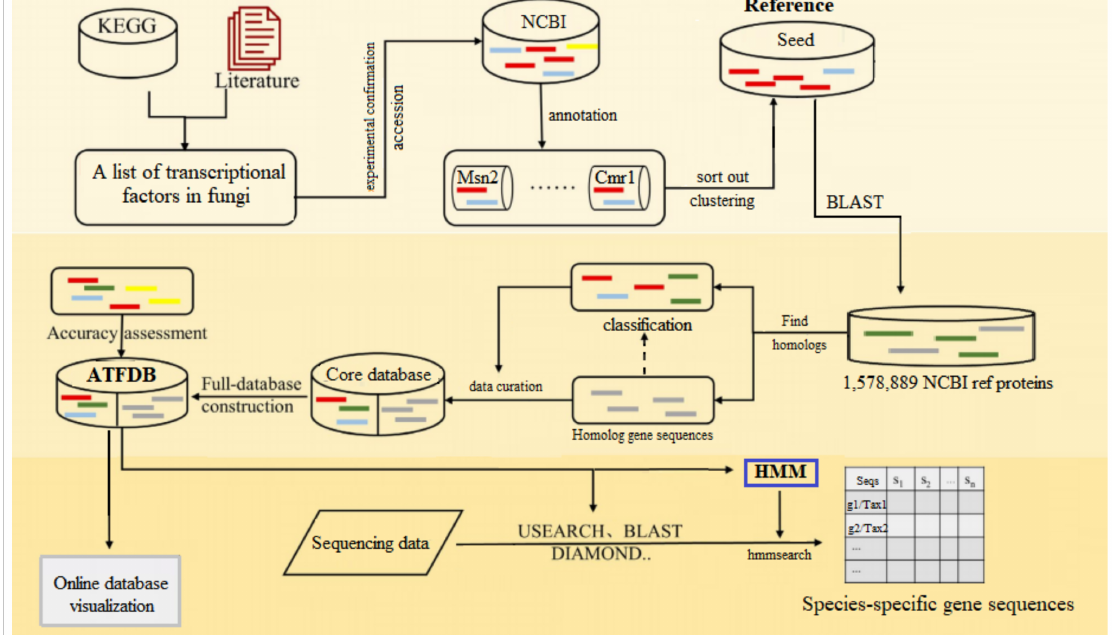
Figure 1. Flowchart of major steps of ATFDB construction. First, a seed database was constructed for selected genes by retrieving protein sequences from the NCBI database using the accession numbers. Second, target genes from the NCBI and their homologs were identified and integrated to construct the core database. At last, all data were uploaded to the online database for visualization, and the trained HMM models were developed to conduct species-specific TFs profiling of Aureobasidium spp. via the sequencing